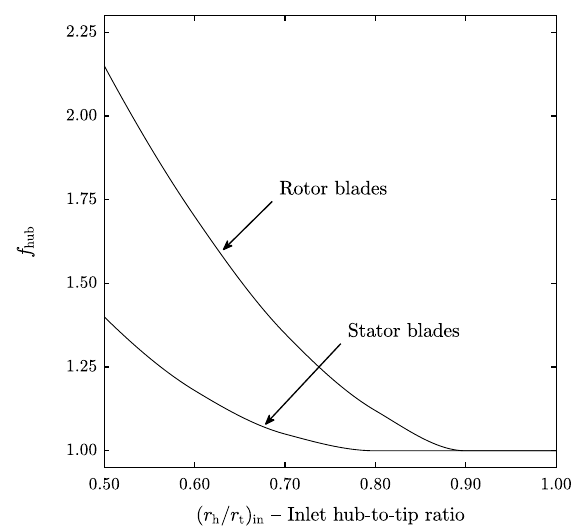
Figure A3. Ratio of Mach number at the hub to Mach number at the mean radius.